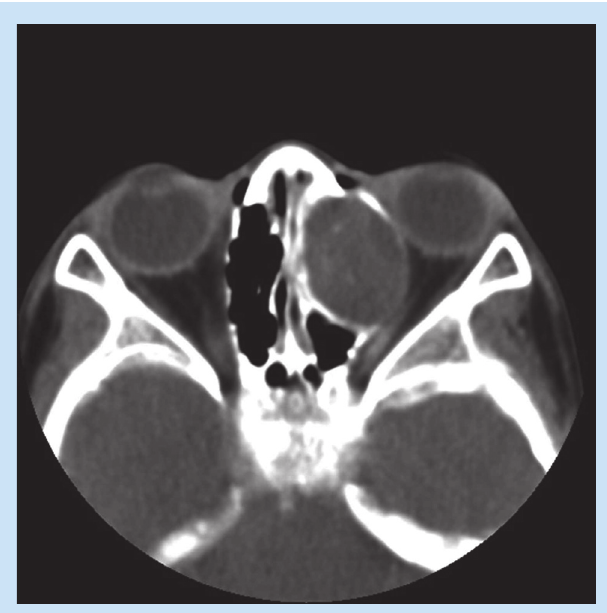
Fig. 1. Axial CT scan (soft-tissue window post contrast) shows a mixed- density soft-tissue expansile mass arising in the left ethmoid sinus, causing thinning and bowing of the medial wall of the left orbit.